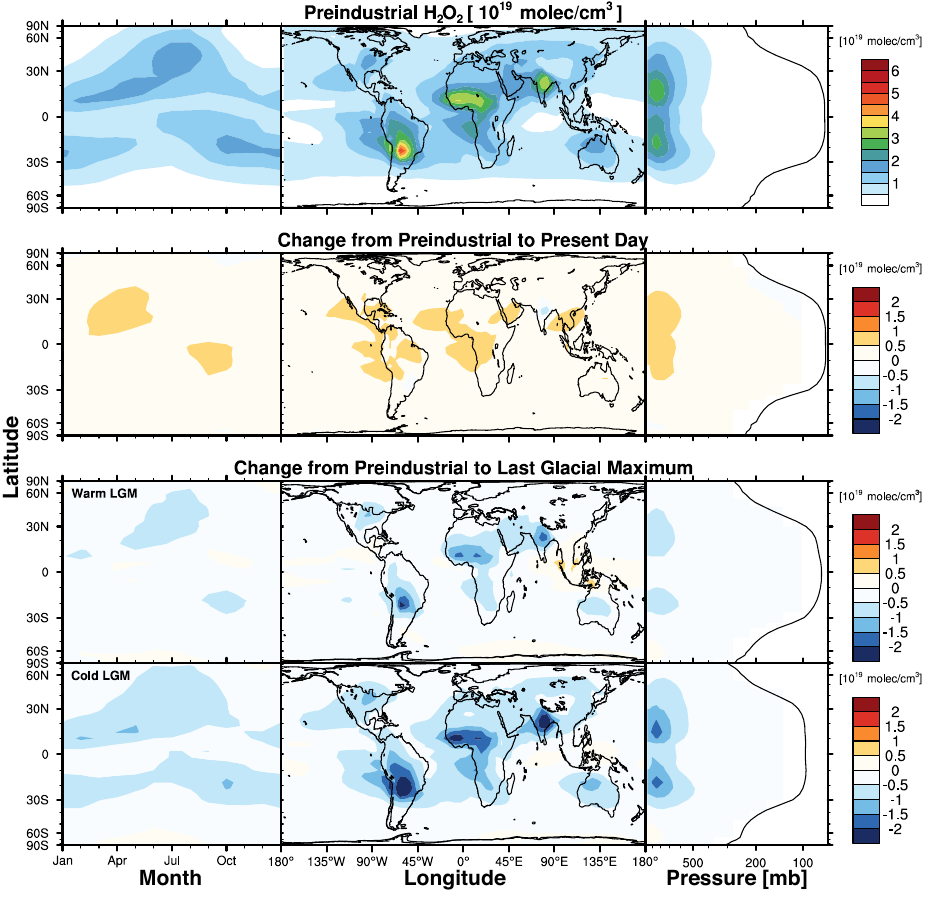
19 moleccm − 3 ). Fig. 15. Same as Fig. 12, but for H 2 O 2 ( 10 19 molec cm (cid:0) 3 ). Fig. 15. Same as Fig. 12 but for H 2 O 2 (10 Table 6. Global sources, sinks, and lifetimes for tropospheric H 2 O 2 Emissions Fixed lightning High fire Low fire LGM LGM LGM Climate Preind. Preind. Preind. Cold Warm Cold